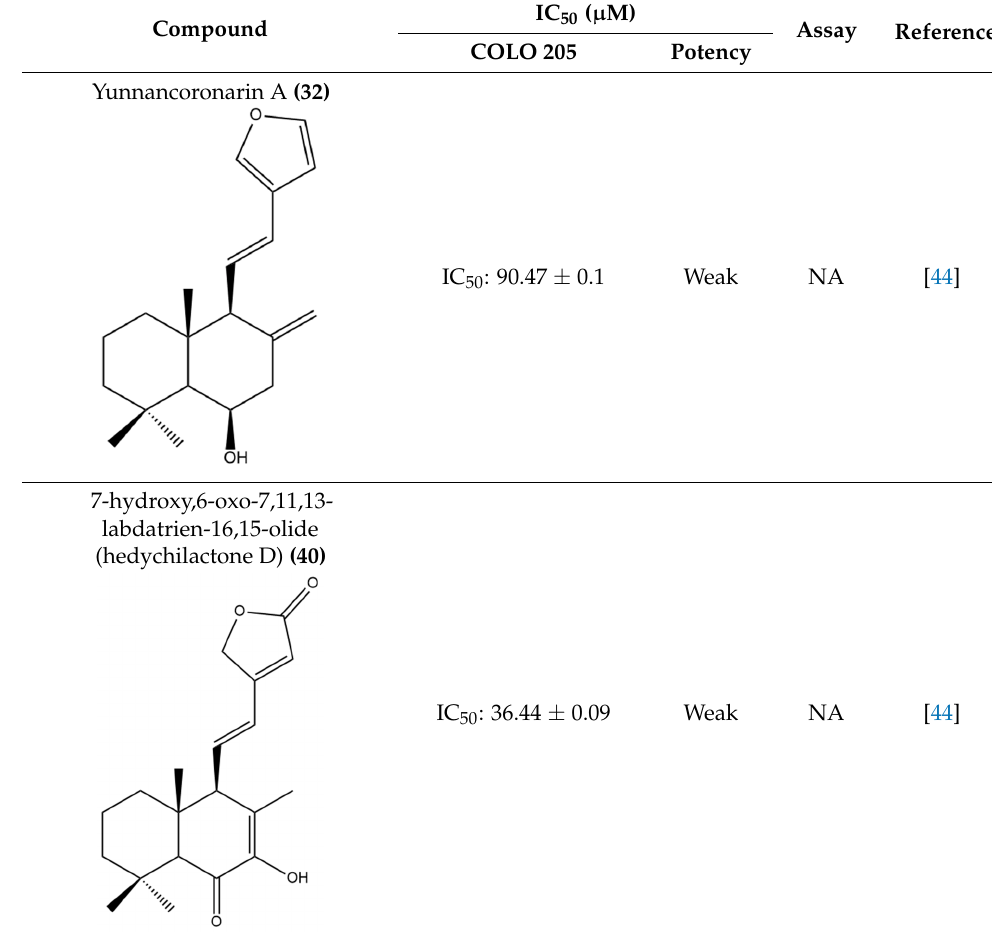
Table 16. Cytotoxic activities of labdane-type diterpenes from the Zingiberaceae against DLD-1 colorectal cancer cell line.